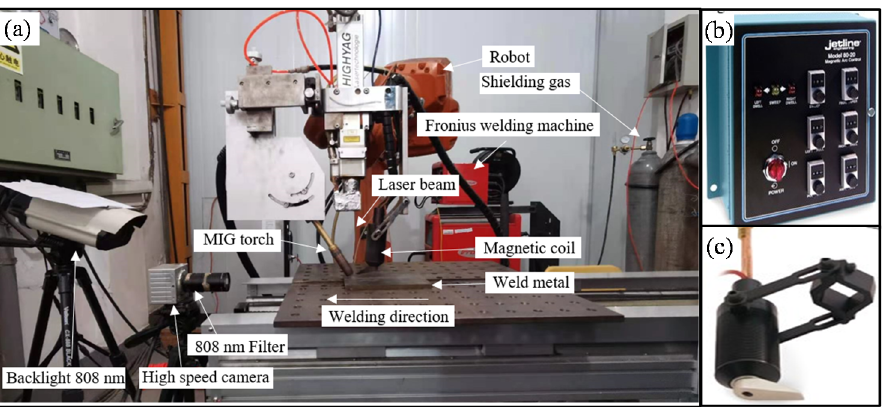
Figure 1. Laser MIG (metal inert gas) hybrid welding experimental equipment: ( a ) experimental setup of laser MIG hybrid welding and ( b ) magnetic arc control unit; ( c ) magnetic arc probe. A high-speed camera (CP80-3M540, Ketianjian Optical and Electronic technology,